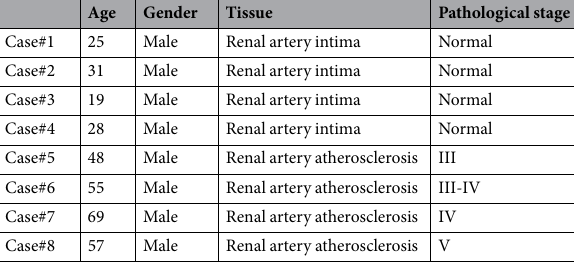
Table 1. Demographic